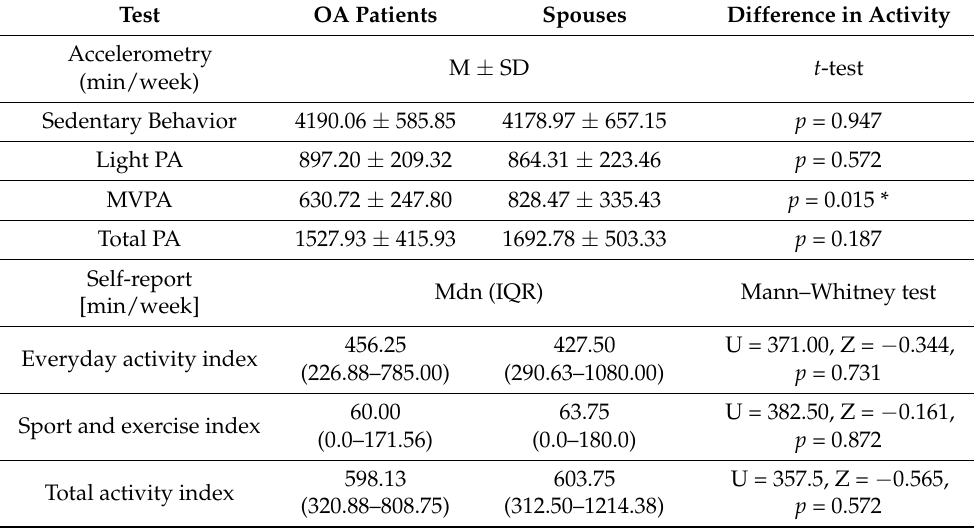
Table 2. Physical activity of OA patients and their spouses.